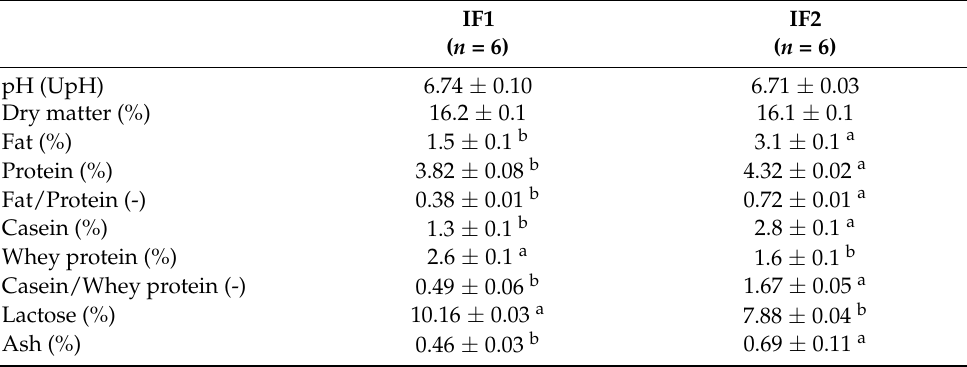
Table 3. Chemico-physical composition of liquid milk-derived formulations IF1 and IF2, to be used in the production of first stage (from 0 to 6 months of age) and follow-on (from 6 to 12 months of age) infant formulae, respectively (mean ±